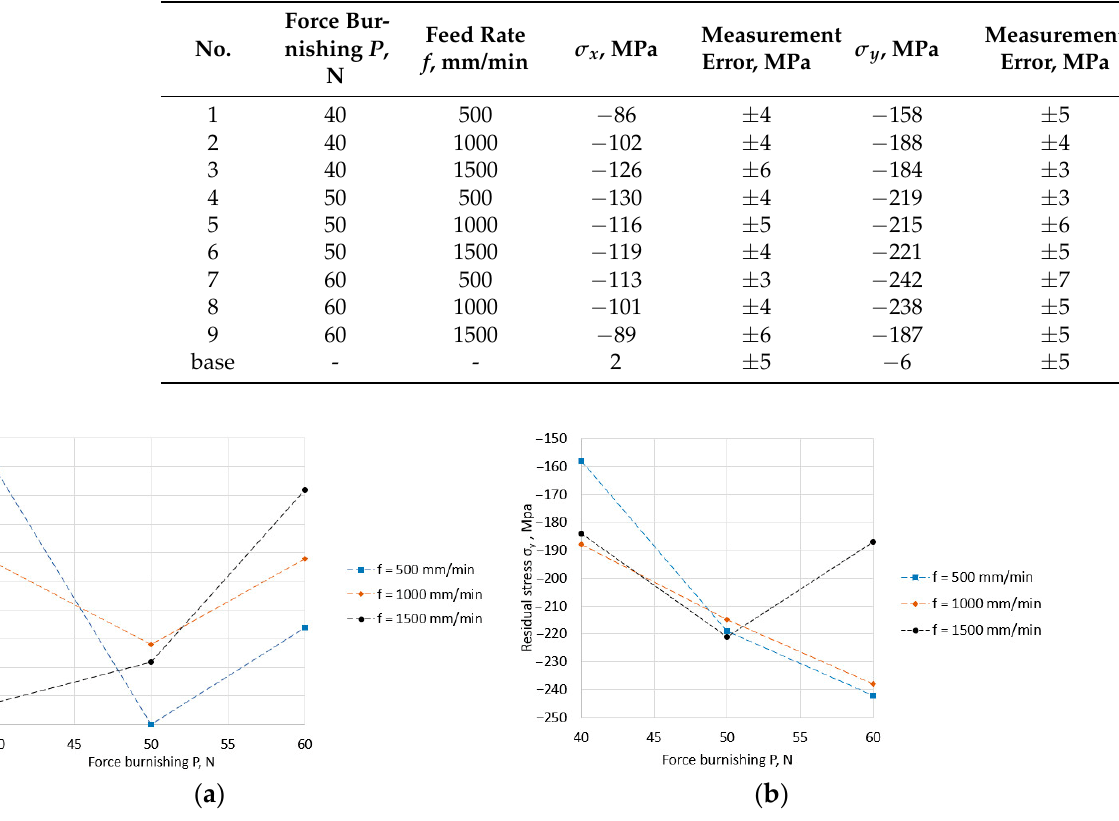
Table 5. The p -value for ANOVA test— 𝜎 (cid:3051) and 𝜎 (cid:3052) .